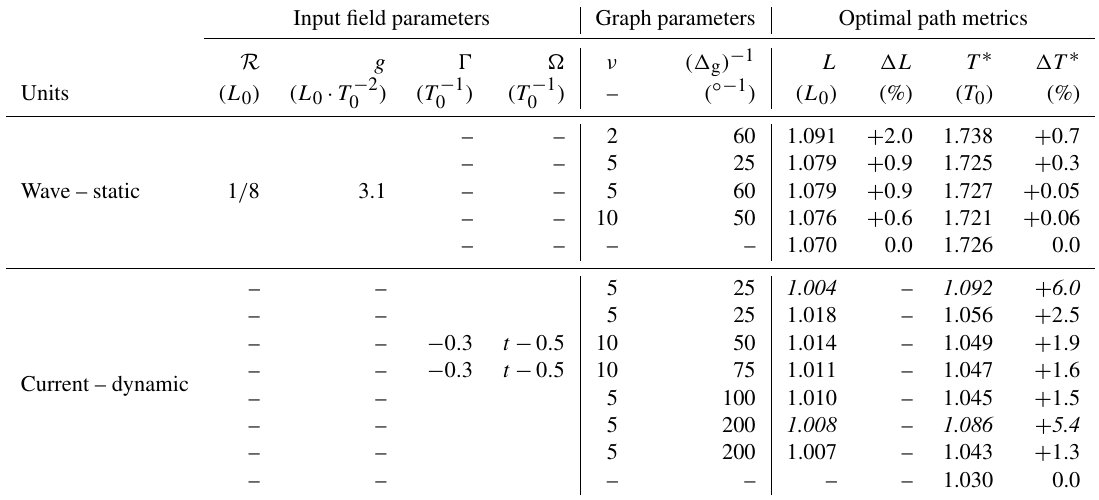
Table 2. Summary parameters of benchmark case studies (see Fig. 2). Length scale L 0 set by the track endpoint distance and timescale T 0 = L 0 /V max are employed throughout ( V max = 21 . 1kn). Values in italics correspond to runs without time interpolation of the edge weights (see Sect. 2.4). Values in the last row of each group refer to the analytic